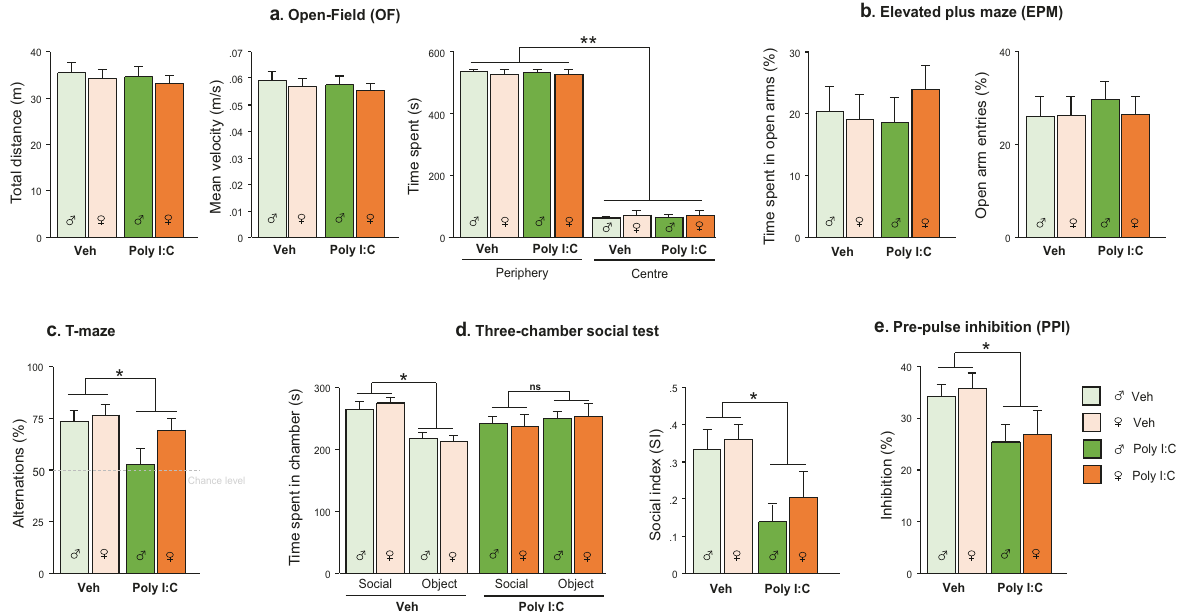
Fig. 1 Behavioral effects of MIA in juvenile/adult offspring. MiA offspring of both sexes did not show alterations in locomotor activity ( a ) and anxiety-like behavior ( a , b ). MIA signi fi cantly affected spontaneous alternation ( c ), social discrimination ( d ) and sensorimotor gating ( e ) in both males and females ( n = 12 M/12 F per group). Data are shown as means ± S.E.M. Two-way ANOVA with post-hoc Tukey ’ s test, * p < 0.05; ** p < 0.01; ns = p > showed a lower percentage of spontaneous alternation in T-maze compared to Veh offspring [main effect of treatment: F(1,44) = 5.627, CHVGGGTATCTAATCC. The PCR products were puri fi ed by means of p < 0.05], with males more impaired as shown by the below chance Agencourt AMPure XP beads (Beckman Coulter, Milan, Italy), quanti fi ed level performance [95% con fi dence intervals (CI), Veh females: 64.91, and then subjected to a further PCR to attach dual Illumina indices 87,86; Veh males: 62.14, 85.09; Poly I:C females: 58.54, 80,39; Poly I:C (Nextera XT Index Kit, Illumina Inc., San Diego, CA, USA) necessary for males: 35.98, 69.57], Fig. 1c. multiplexing and equimolar ratios of amplicons from individual samples Poly I:C offspring, regardless of sex, exhibited decreased were pooled before sequencing on the Illumina platform using high preference for the social stimulus in the three-chamber test, as throughput screening Illumina MiSeq instrument. Sequence data gener- they spent less time exploring the social chamber [treatment*ch- ated as FASTQ fi les, deposited in the Arrayexpress repository under amber: F(1,44) = 6.517, p < 0.05, p < 0.01 after post-hoc compar- accession code E-MTAB-11150, were analyzed using the 16S Metage- nomics GAIA 2.0 software as already described [28]. Read pairs were isons] and snif fi ng the social stimulus as indicated by social index